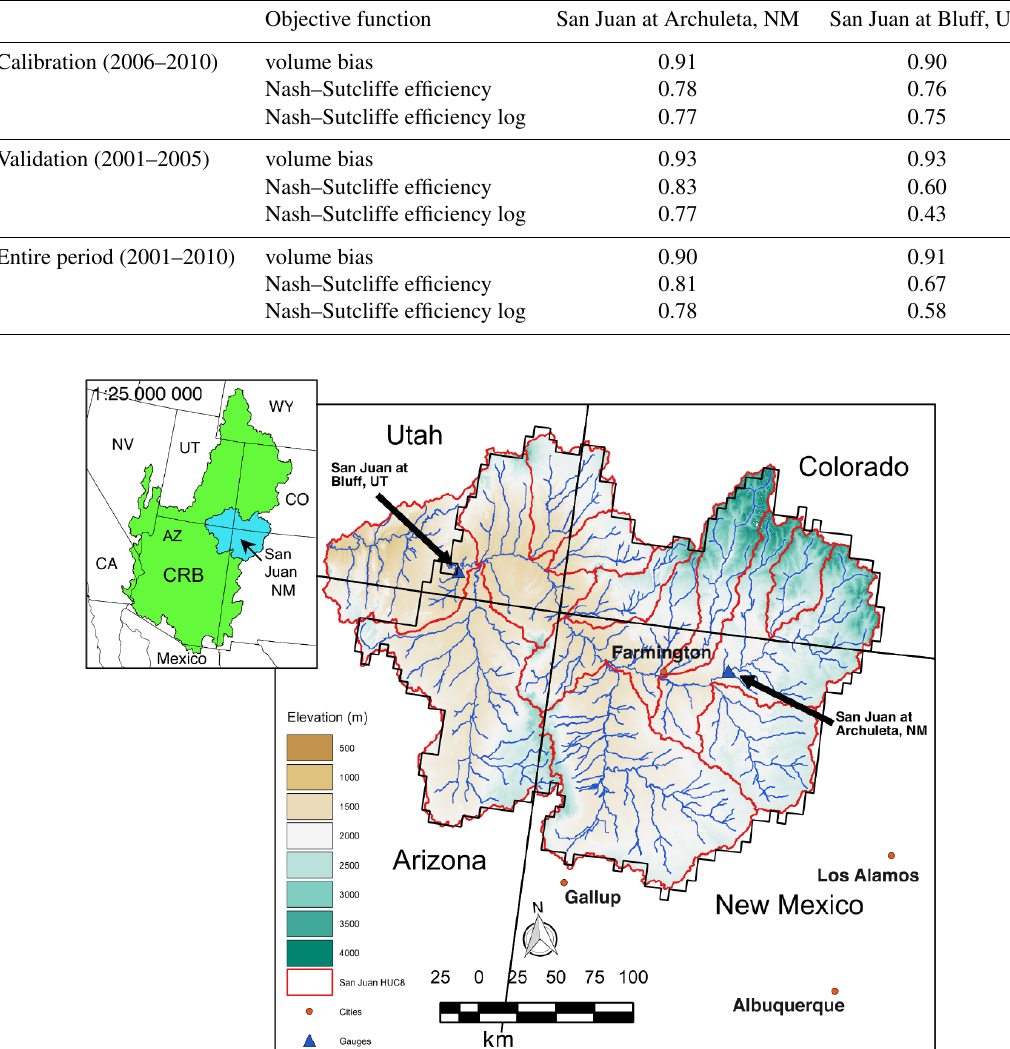
Table 1. Calibration, validation, and entire period of record monthly statistics for simulated to naturalized streamflow for the San Juan at Archuleta, NM, and San Juan at Bluff, UT.